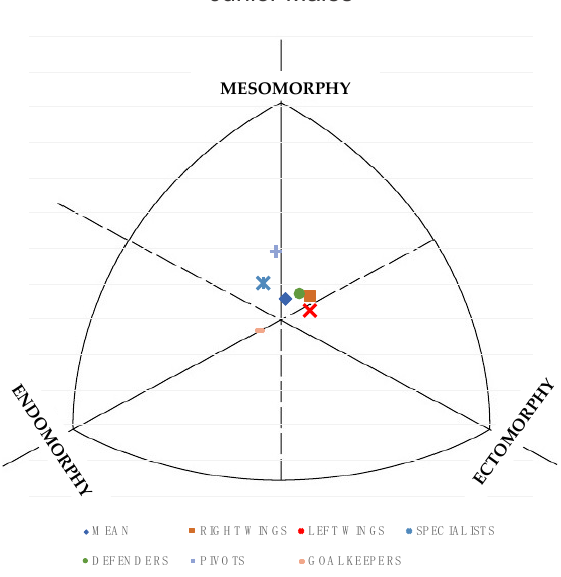
Figure 1. Somatotype distribution of elite male junior handball players.